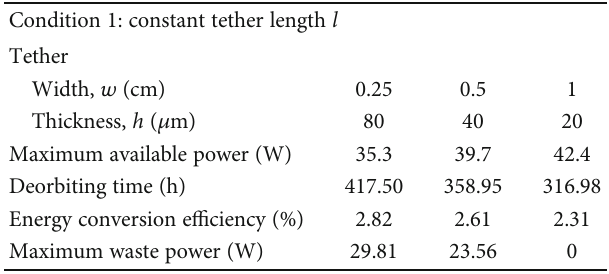
Table 3: Battery performance under di ff erent tether parameters.